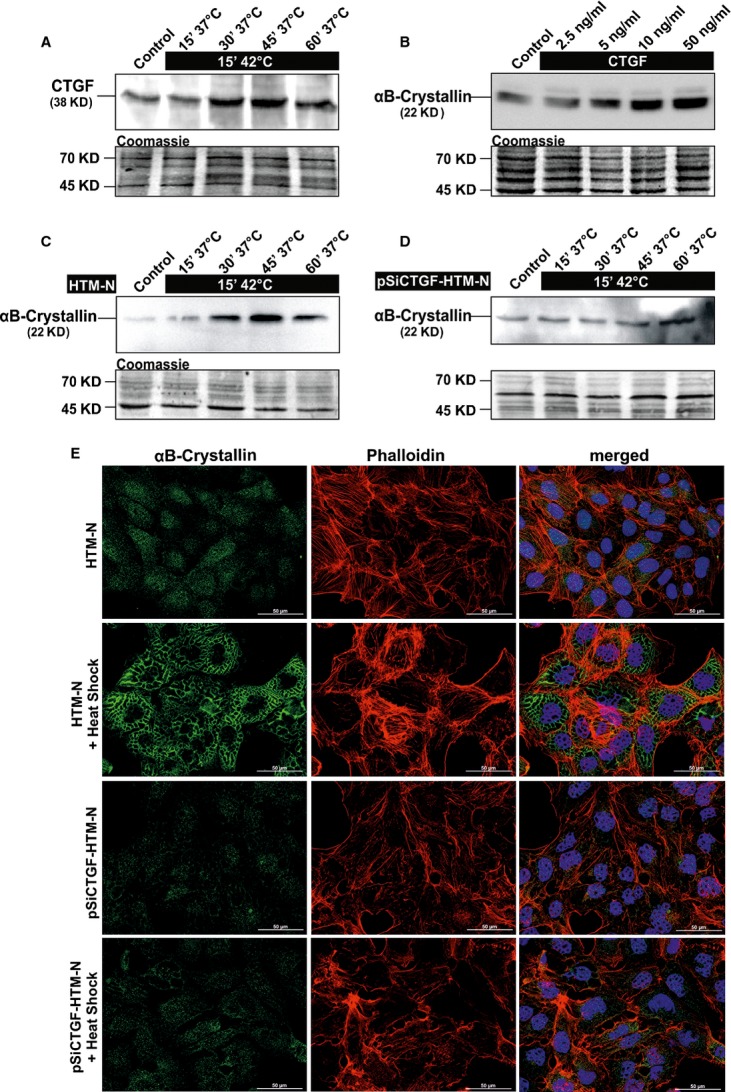
Effect of heat shock on the expression of CTGF and αB-crystallin. (A) Western blot analysis for CTGF in cell extract of HTM-N cells after heat shock at 42°C and recovery phase of 15–60 min. After 30 min. the CTGF expression was increased up to 3.3 ± 0.4-fold (P < 0.05) and maintained at this level until 60 min. (B) Western blot analysis for αB-crystallin in cell extract of HTM cells after treatment with 2.5–50 ng/ml of CTGF for 24 hrs. αB-crystallin was significantly increased after CTGF treatment for 24 hrs (3.2 ± 0.3-fold, P < 0.05). (C and D) Western blot analysis for αB-crystallin in cell extracts of HTM-N (C) and pSiCTGF HTM-N cells (D) after heat shock at 42°C and recovery phases of 15–60 min. Densitometric evaluation of HTM-N cells showed a maximum of 4.1 ± 0.3-fold after 30 min. (P < 0.05) while there was only a slight induction of 2.1 ± 0.5-fold observed after 60 min. in pSiCTGF HTM-N cells. Membranes were stained with coomassie blue to confirm equal loading of proteins. (E) Immunohistochemical staining of αB-crystallin (green) and actin fibres (phalloidin, red) in HTM-N and pSiCTGF HTM-N cells 30 min. after heat shock. HTM-N cells showed a more intense staining for αB-crystallin and an increased formation of actin stress fibres after heat shock, while there was no increase in pSiCTGF HTM-N cells. Scale bar = 50 μm.